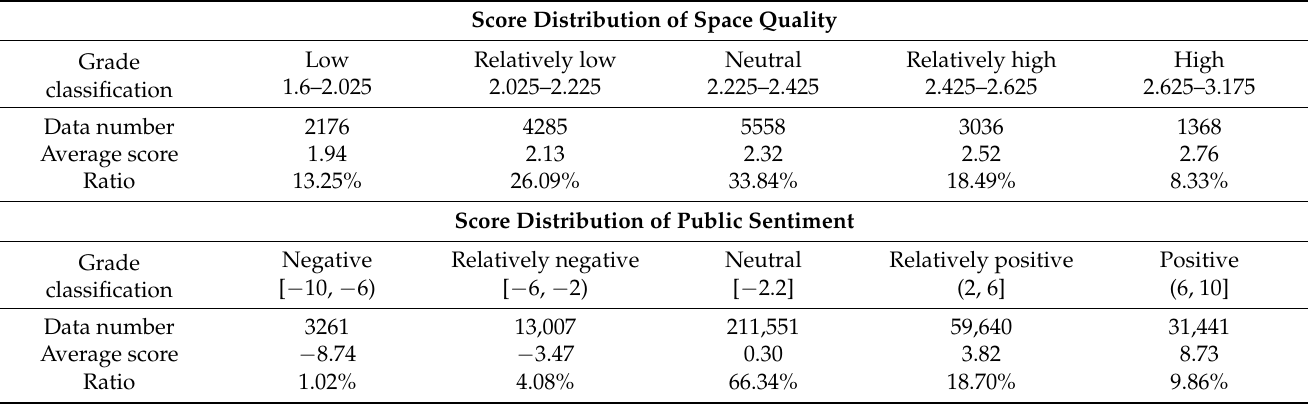
Table 8. Score distribution of spatial quality and public